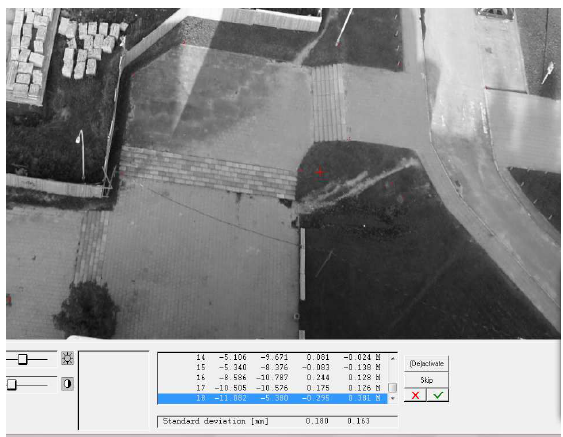
Figure 5. Fragment of results from exterior image orientation – UAV Photogrammetry